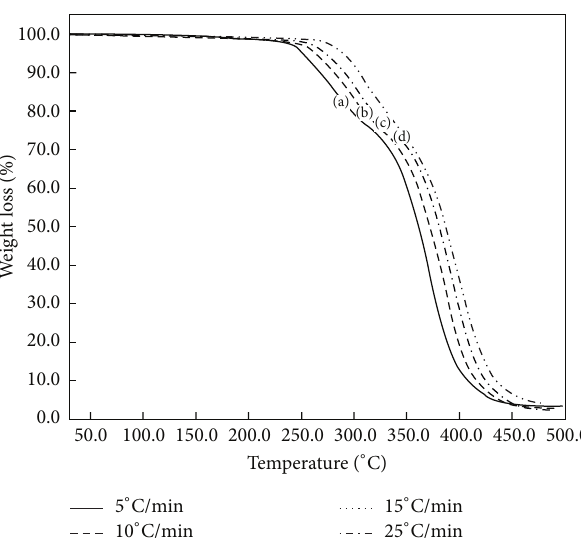
Figure 8: The thermal degradation curves of poly(APMA) at different heating